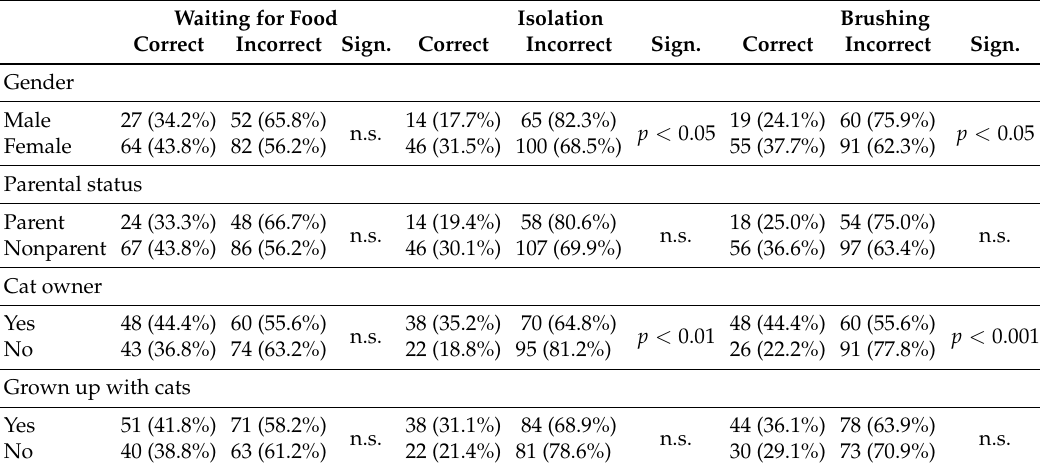
Table 2. Absolute frequencies (and percentages) of correct or incorrect assignment of medioid meows in each of the three contexts, depending on individual characteristics and level of experience with cats of the interviewed